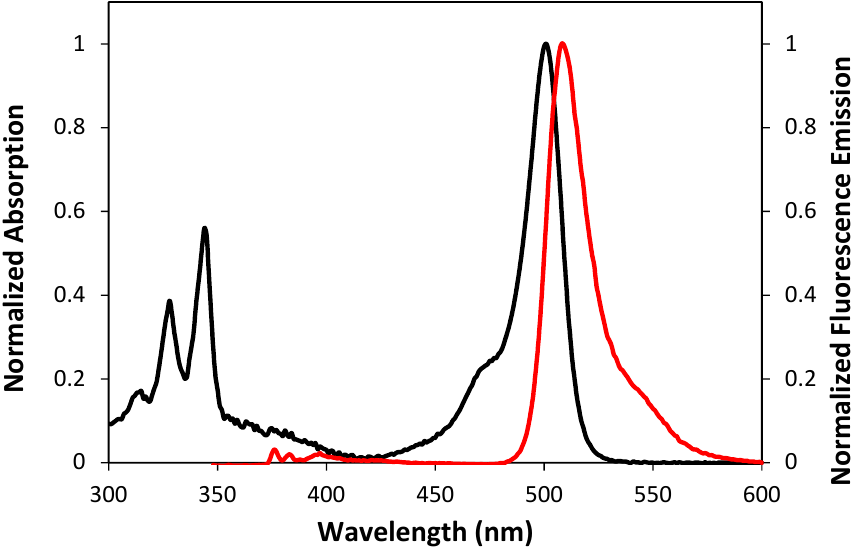
Figure 2. Absorption (black) and emission (red) spectra for the compound 4 .